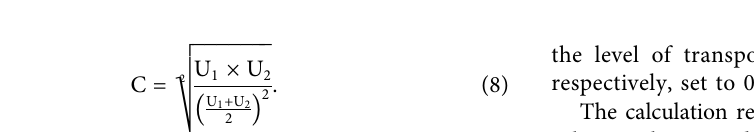
Frontiers in Environmental Science |